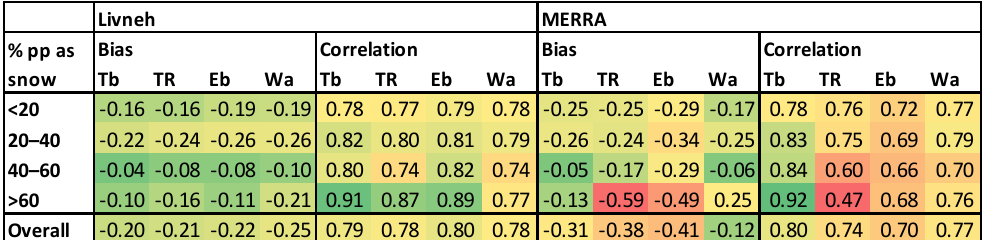
Figure 4. Performance of snowmelt models (median of catchments) disaggregated by percentage of precipitation falling as snow (%pp as snow). Validation data for SCE calibration of model M4. The cells were color-coded using a green (good performance)—yellow—red (bad performance) scale.